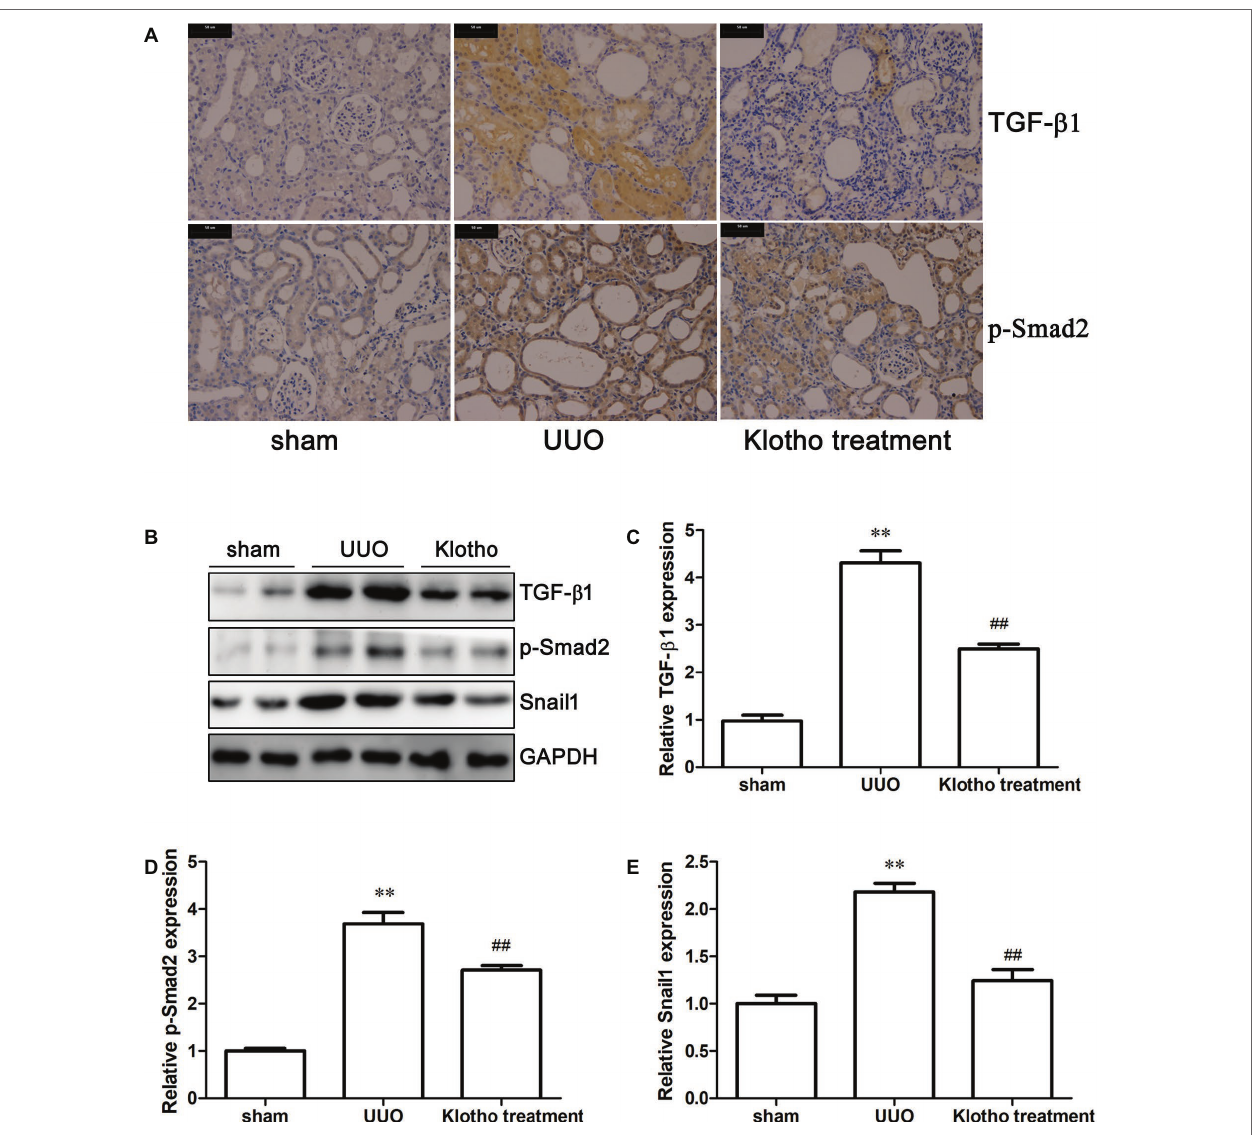
FIGURE 3 | Klotho administration attenuates UUO-triggered EndoMT via regulating TGF- β 1/Smad2/Snail1 signaling pathway. (A) Immunohistochemical staining showing the expression of TGF- β 1 and p-Smad2 (S255) in experimental groups. (B) Representative images of TGF- β 1, p-Smad2 (S255), and Snail1 were analyzed by western blotting. Quantification of TGF- β 1, p-Smad2 (S255), and Snail1 is shown in (C) – (E) , respectively. ** p ≤ 0.01 versus sham group; ## p ≤ 0.01 versus UUO